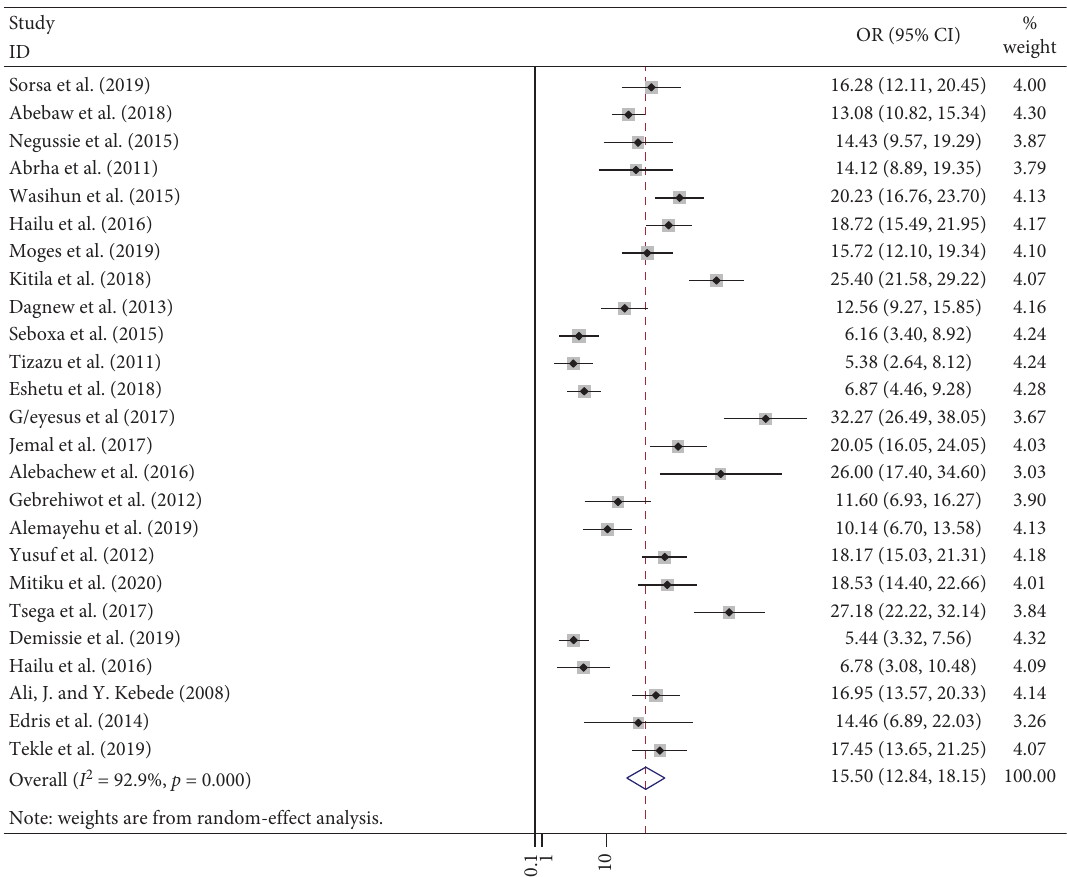
Figure 3: Forest plot showing the pooled prevalence of Gram-positive bacterial isolates among patients with suspected bloodstream infections in